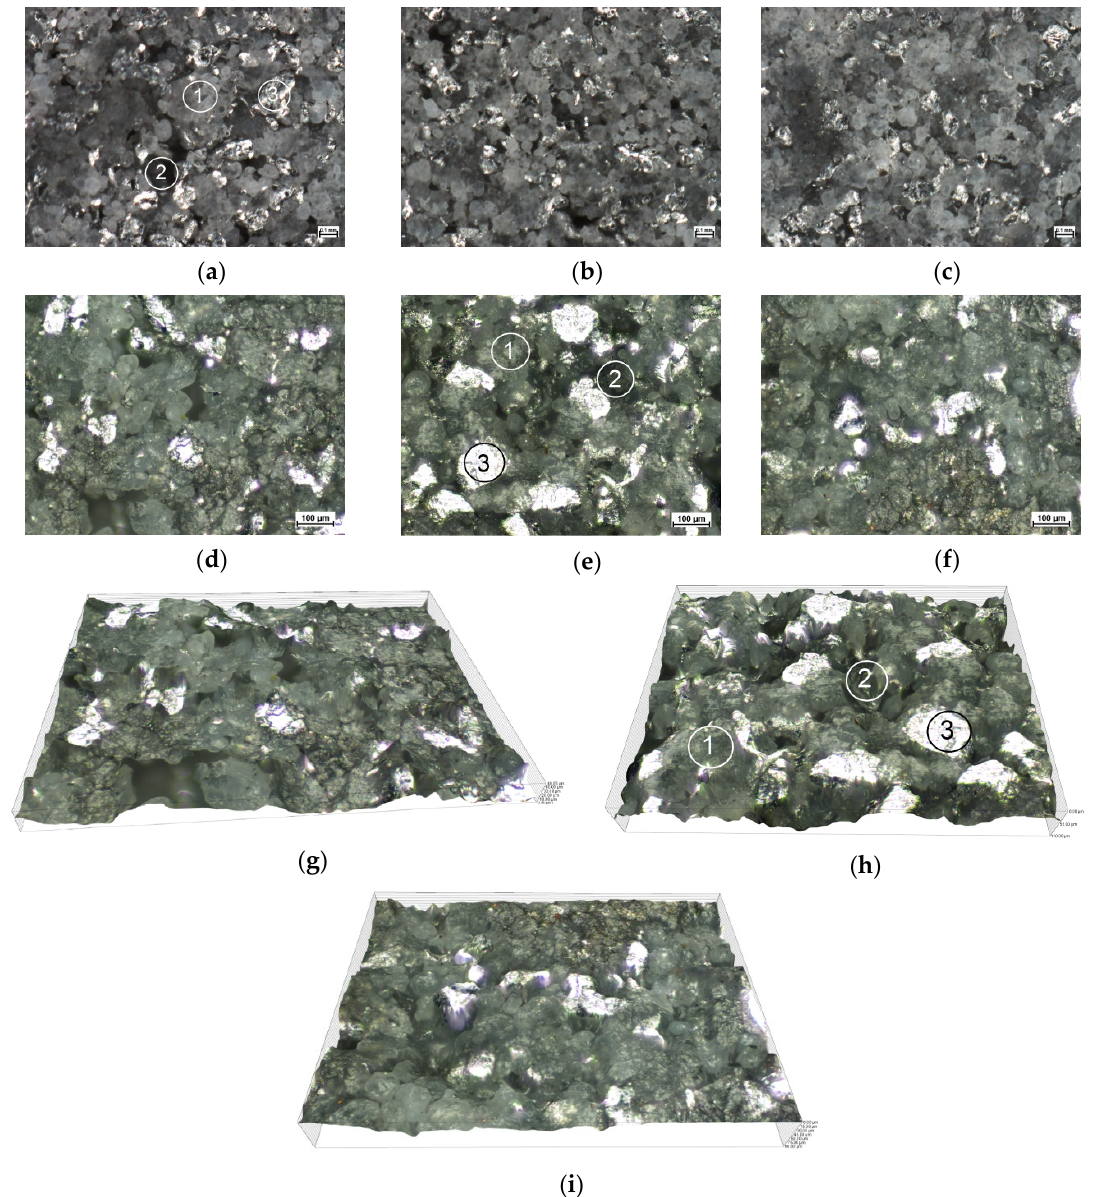
Figure 4. Microscopic images of the specimen surface; ( a ), ( b ), ( c )—80× magnification; ( d ), ( e ), ( f )—100× magnification; ( g ), ( h ), ( i )—3D views, 100× magnification; ( a ), ( d ), ( g )—X direction; ( b ), ( e ), ( h )—Y direction; ( c ), ( f ), ( i )—Z direction; 1—sintered grains of the polyamide powder (P-12); 2—void; 3—aluminum powder grain.